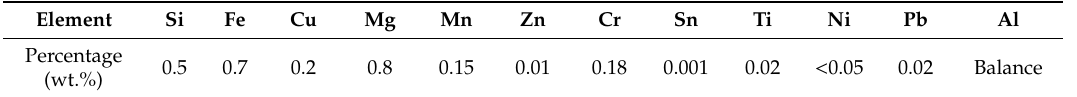
Table 1. Chemical Composition of Al6061 Alloy.